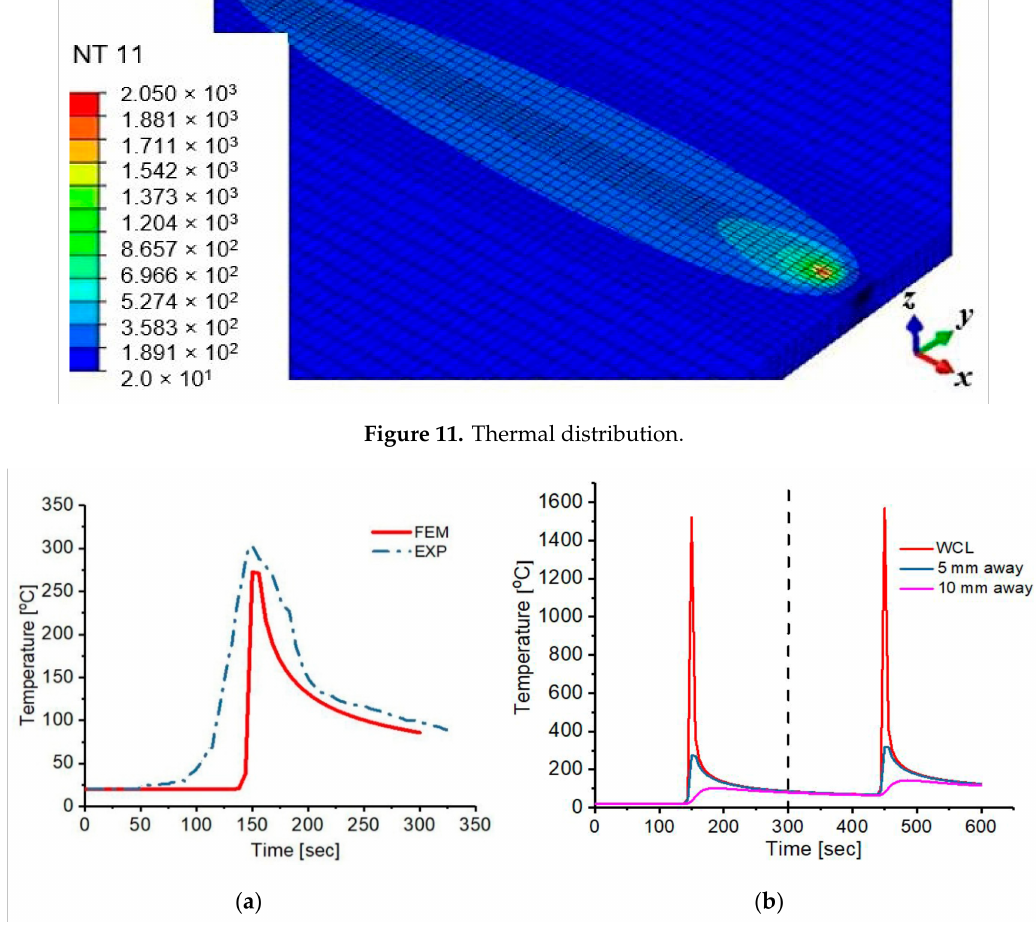
Figure 12. ( a ) Compared experimental and FEM temperature history at 5 mm away from the heat source ( b )The predicted temperature history of various positions during the first and second